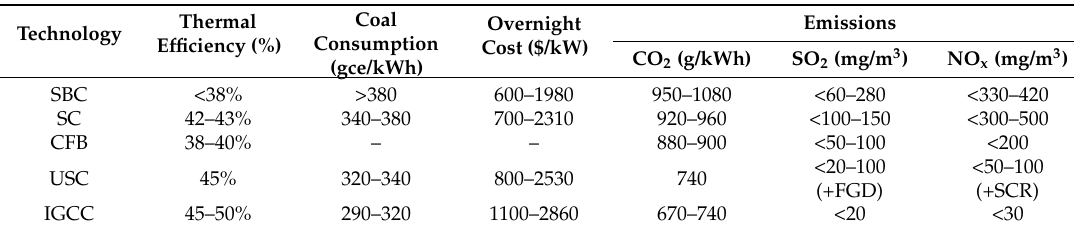
Table 2. Performance comparison of CCTs.